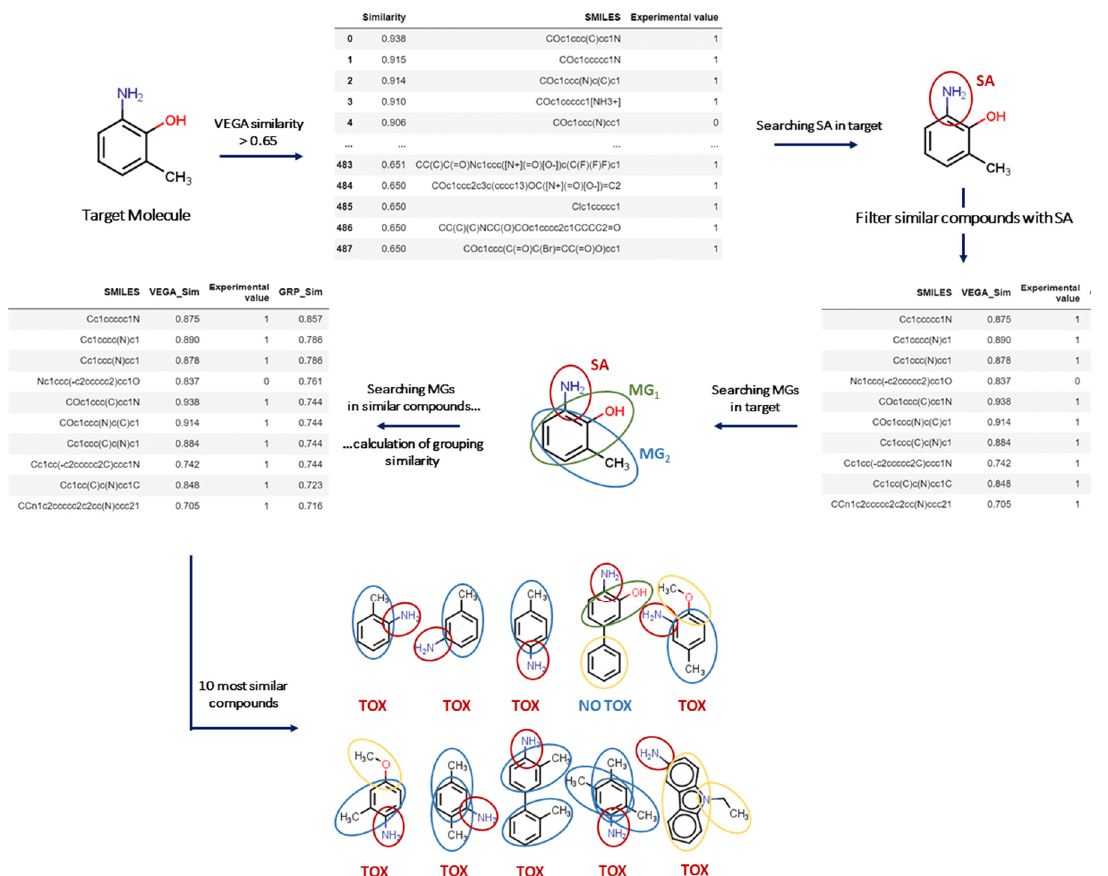
Figure 1. Case Study—An overall scheme of the Virtual Extensive Read-Across (VERA) algorithm. Given a target, VERA searches for similar compounds according to the Virtual models for Evaluating the properties of chemicals within a Global Architecture (VEGA) similarity index (>0.65) and the presence of structural alerts (SA, red circle) if the target substance contains any; if all similar substances are concordant in experimental values (toxic or NON-toxic), the target substance will be labelled accordingly. In the figure, molecular groups (MGs) in common between the target and similar compounds (MG 1 , green circle; MG 2 , blue circle) and not in common (yellow circles) are highlighted.